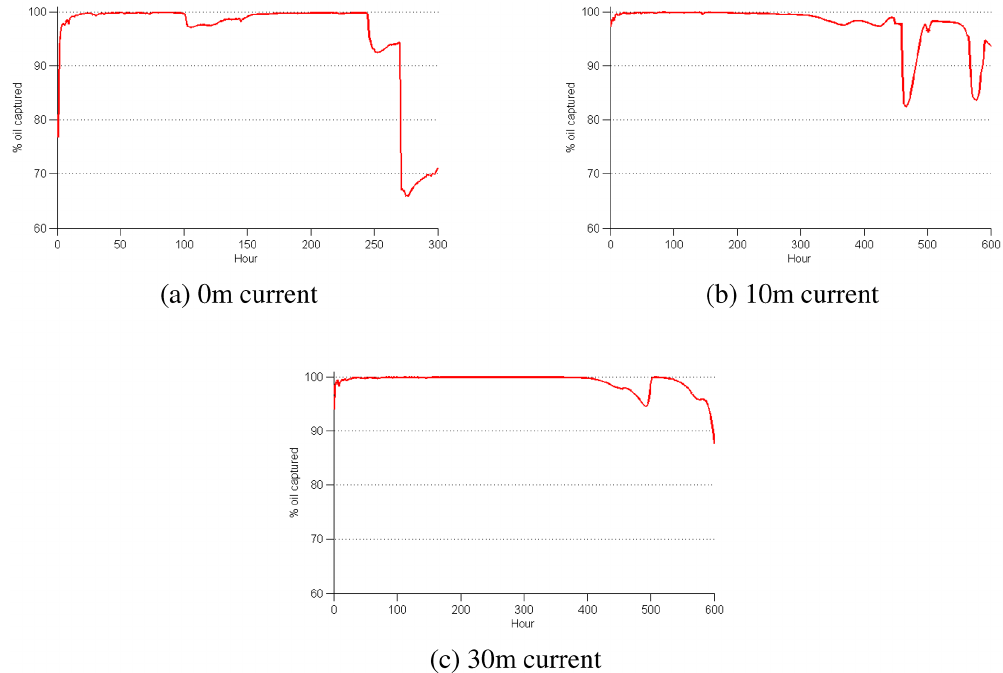
Figure 10. Percentage of oil captured by CranSLIK’s forecast of the slick’s convex hull for the Lebanon case, using the current at different depths as the advective current.